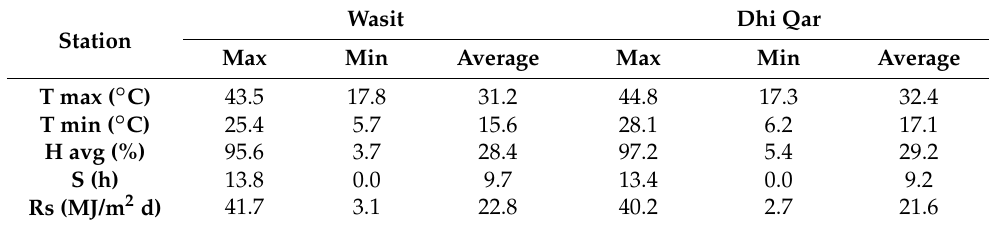
Figure 1. The geographical location of Wasit and Dhi Qar provinces. Table 1. Average meteorological data used in the studied stations.